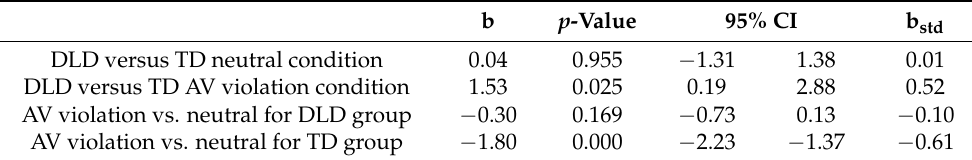
Table 6. Posterior MMN model simple effects for the group-by-condition interaction. b p